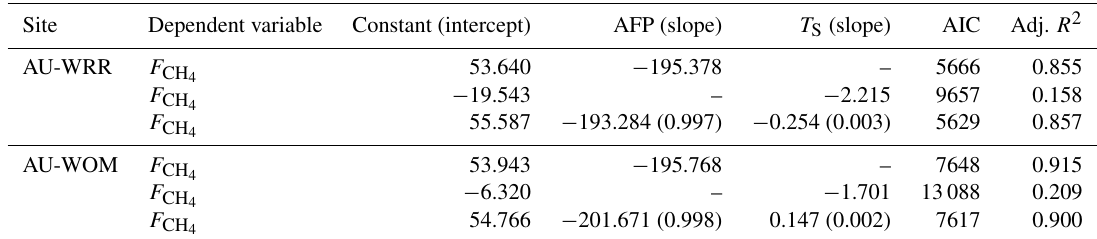
Table 2. Parameters and coefficients of determination (Adj. R 2 ) of selected linear models in combination with results of a restricted maximum likelihood analysis (REML) explaining seasonal variability in mean chamber cycle methane flux ( F CH stand, Wombat State Forest, Victoria (AU-WOM) and at a mixed E. obliqua and E. regnans forest stand, Warra LTER, Tasmania, Australia (AU-WRR). Predictors: T S (soil temperature) and AFP (air-filled porosity). REML results: Akaike information criterion (AIC); Estimate of importance for models containing both predictors are in